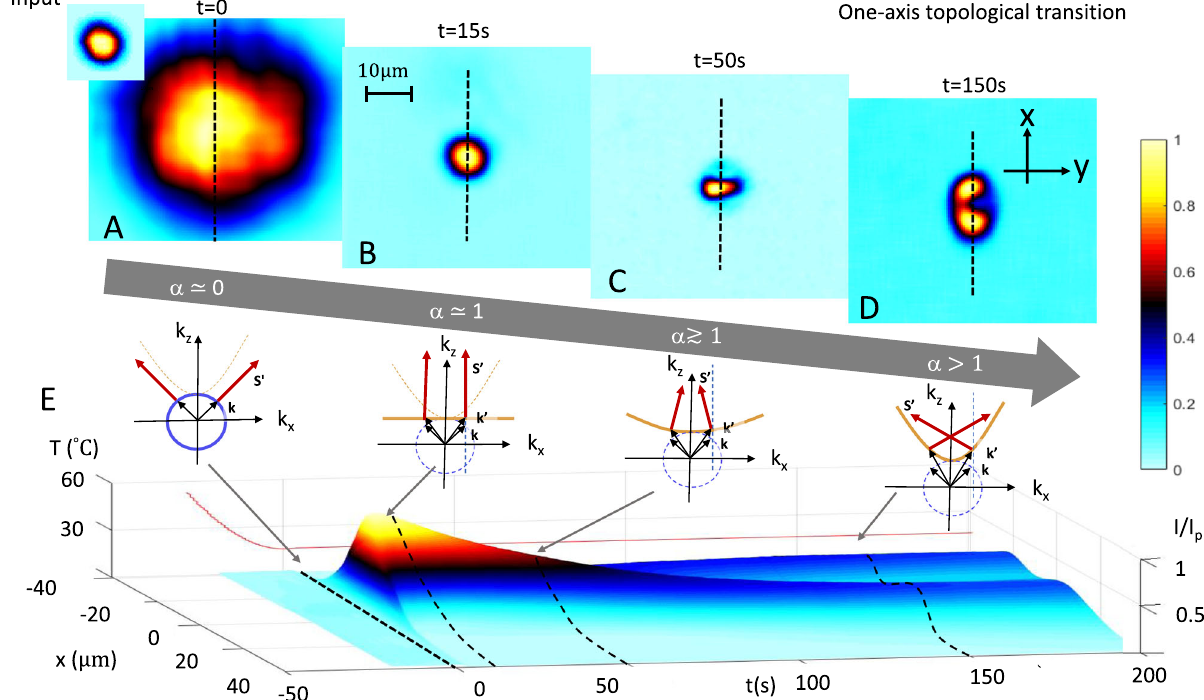
Fig. 2 Observation of twin-beam formation in a 1 + 1D topological transition. A Transverse xy intensity distribution I normalized to the peak intensity of the beam I p at the input facet as transmitted by the mask (inset) that diffracts to the output after L z = 2.2 mm propagation to 72 μ m (FWHM) for t = 0 (i.e., α = 0). B Output distribution for the scale-free optics regime ( t = 15 s and corresponding α = 1). C The beam now self-induces the transition at t = 50 s, leading to D the signature non-diffracting splitting regime for t > 150 s ( α > 1). E The self-induced transition seen in time (and corresponding estimated value of α ) using the x intensity pro fi le (dashed lines in A – D ) (Source data are provided as a Source Data fi